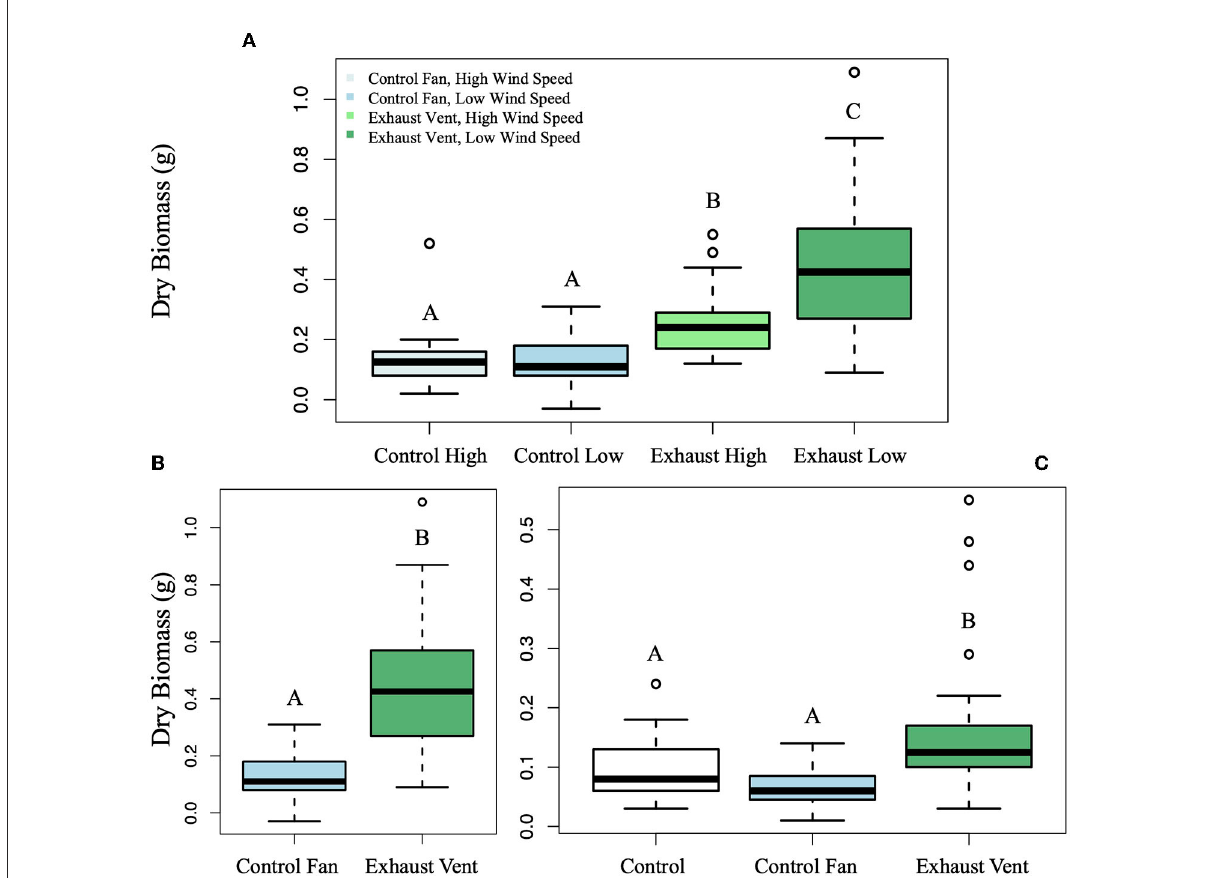
FIGURE5 Average dry weight of spinach and corn plants in response to Exhaust Vent air. (A) Spinach was grown in Fall 2018 next to two fans at a higher wind speed (17 mph) and two at a lower speed (10 mph) and one of each of these was a Control Fan and Exhaust Vent. Between the Exhaust Vents, the spinach plants exposed to high wind speeds were smaller ( p < 0.001). Even with this, the Exhaust Vent was able to recover growth compared to both the low ( p = 0.0058) and high-speed ( p = 0.0028) Control Fans. At only low wind speeds there was a significant increase in (B) dry biomass ( p < 0.001) with exposure to exhaust air. These data were from harvest 3. (C) Corn grown in Spring 2019 next to the Exhaust Vent was larger than at both the Control Fan ( p < 0.001) and control garden ( p = 0.0045). Different capital letters indicate statistically significant differences among